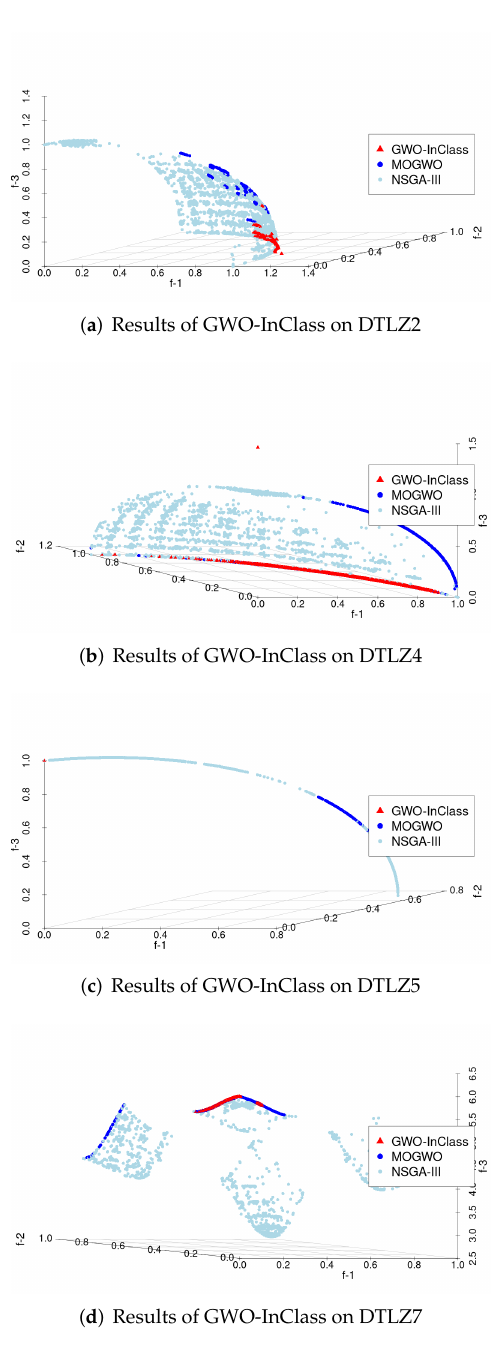
Figure 2. Results of GWO-InClass on some 3-objective